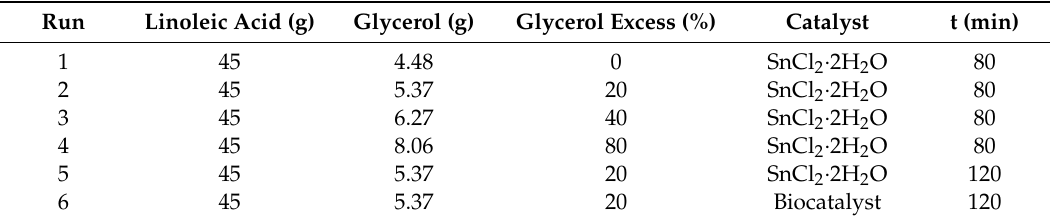
Table 1. Components and incubation time of the esterification reactions of commercial linoleic acid with di ff erent amounts of glycerol at 160 ◦ C. Run Linoleic Acid (g)